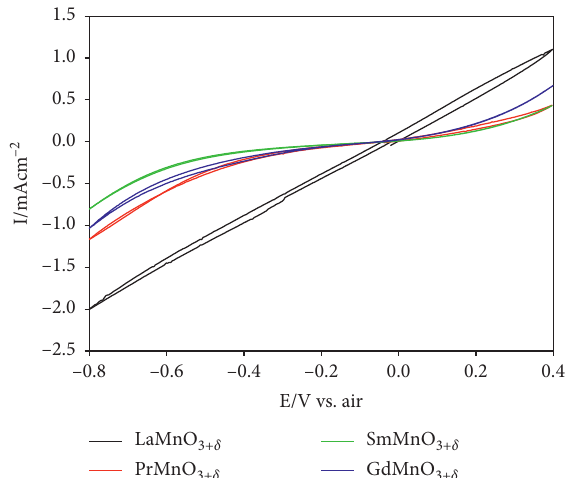
Figure 6: Voltammograms recorded at 300C in 1% NO in Ar on the four manganite-based perovskites with different A-site cations. The voltammograms are recorded with a sweep rate of 1mV/s. Also at this temperature, the LaMnO 3+ δ perovskite is the most active. The differences between the three other manganite-based perovskites are smaller at this temperature.